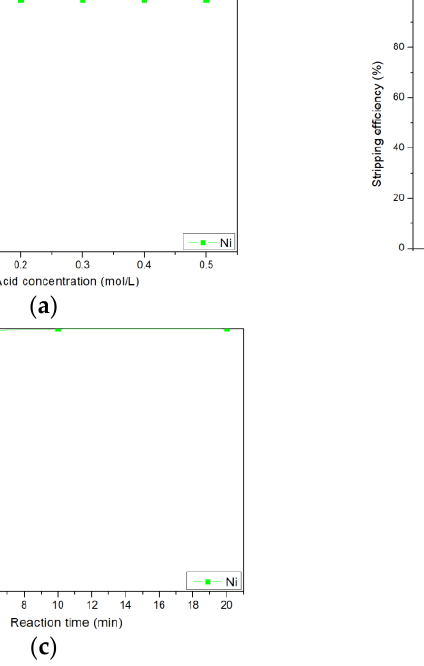
Figure 7. Effects of ( a ) acid concentration (O/A = 1, t = 15 min), ( b ) oil – water ratio ([H 2 SO 4 ] = 0.1 M, t = 15 min), and ( c ) reaction time ([H 2 SO 4 ] = 0.1 M, O/A = 1) on nickel stripping.